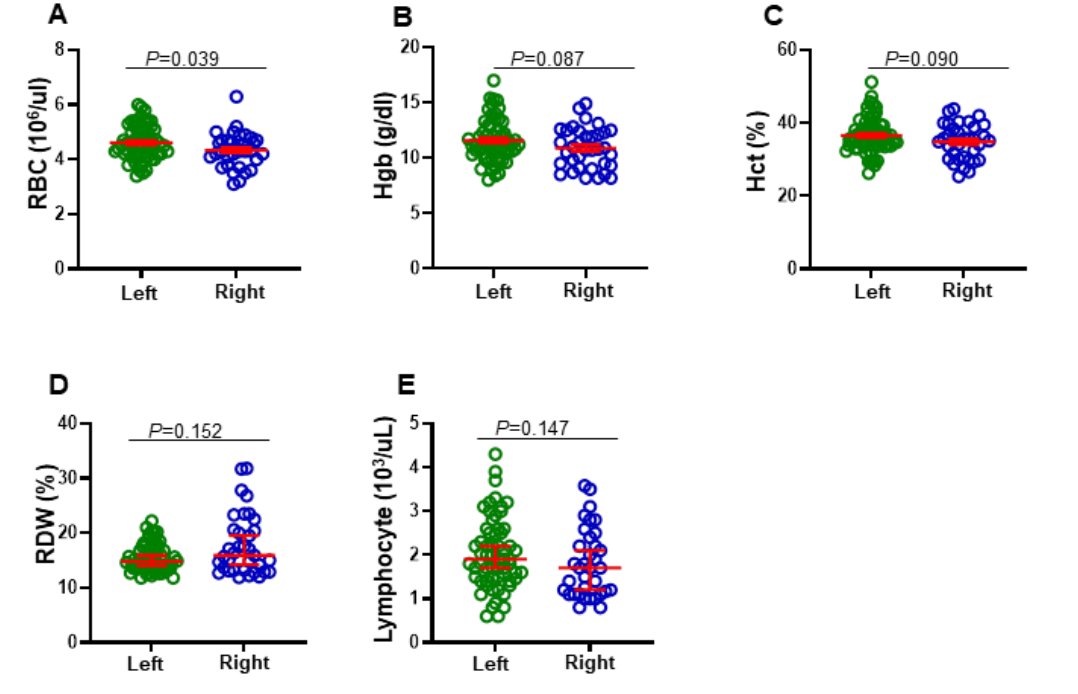
Figure 2. Comparison of some CBC parameters based on the tumor anatomical location of CRC patients. Patients were divided into two groups based on left-sided and right-sided tumors. Scatter plots show the differences in levels of RBC ( A ), Hgb ( B ), Hct ( C ), RDW ( D ), and lymphocytes ( E ). Red lines represent median ± 95% CI or mean ±